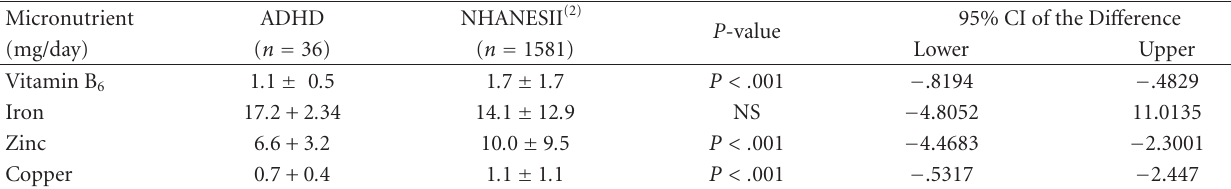
Table 3: Micronutrient intake data in ADHD children aged 6–12 years compared to population data (1) . Micronutrient